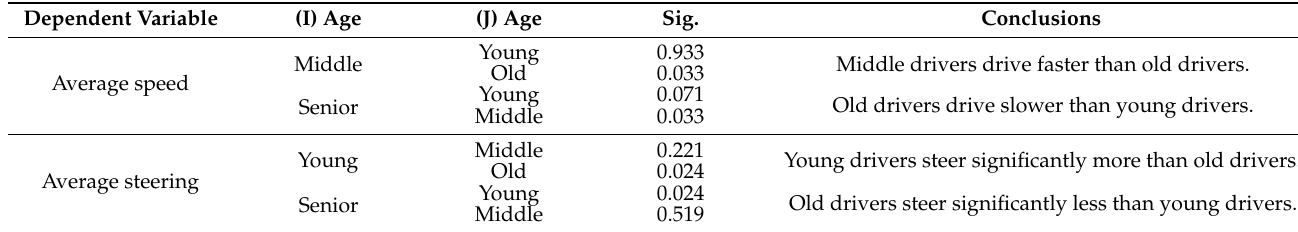
Table 8. Post hoc results to highlight differences in age